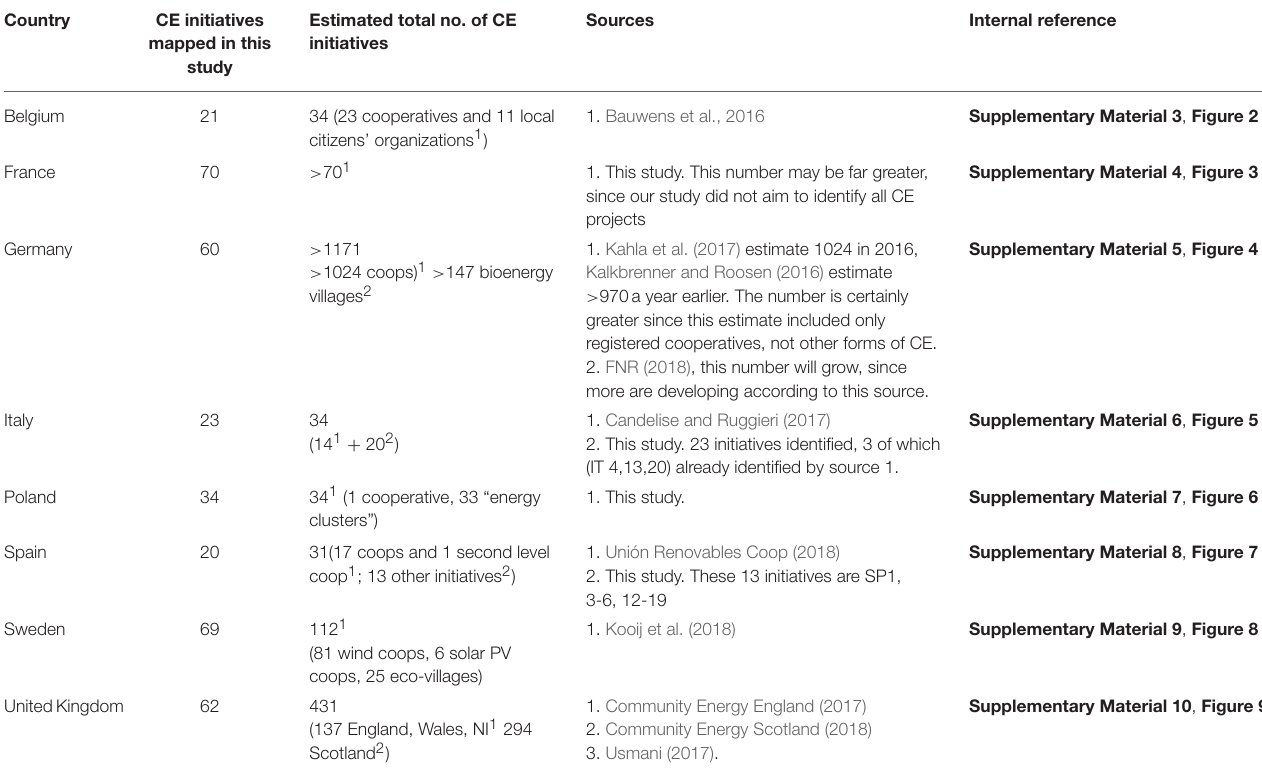
TABLE 1 | Numbers of CE initiatives mapped by this study, and estimated total numbers of CE initiatives from literature. Country CE initiatives Estimated total no. of CE mapped in this study